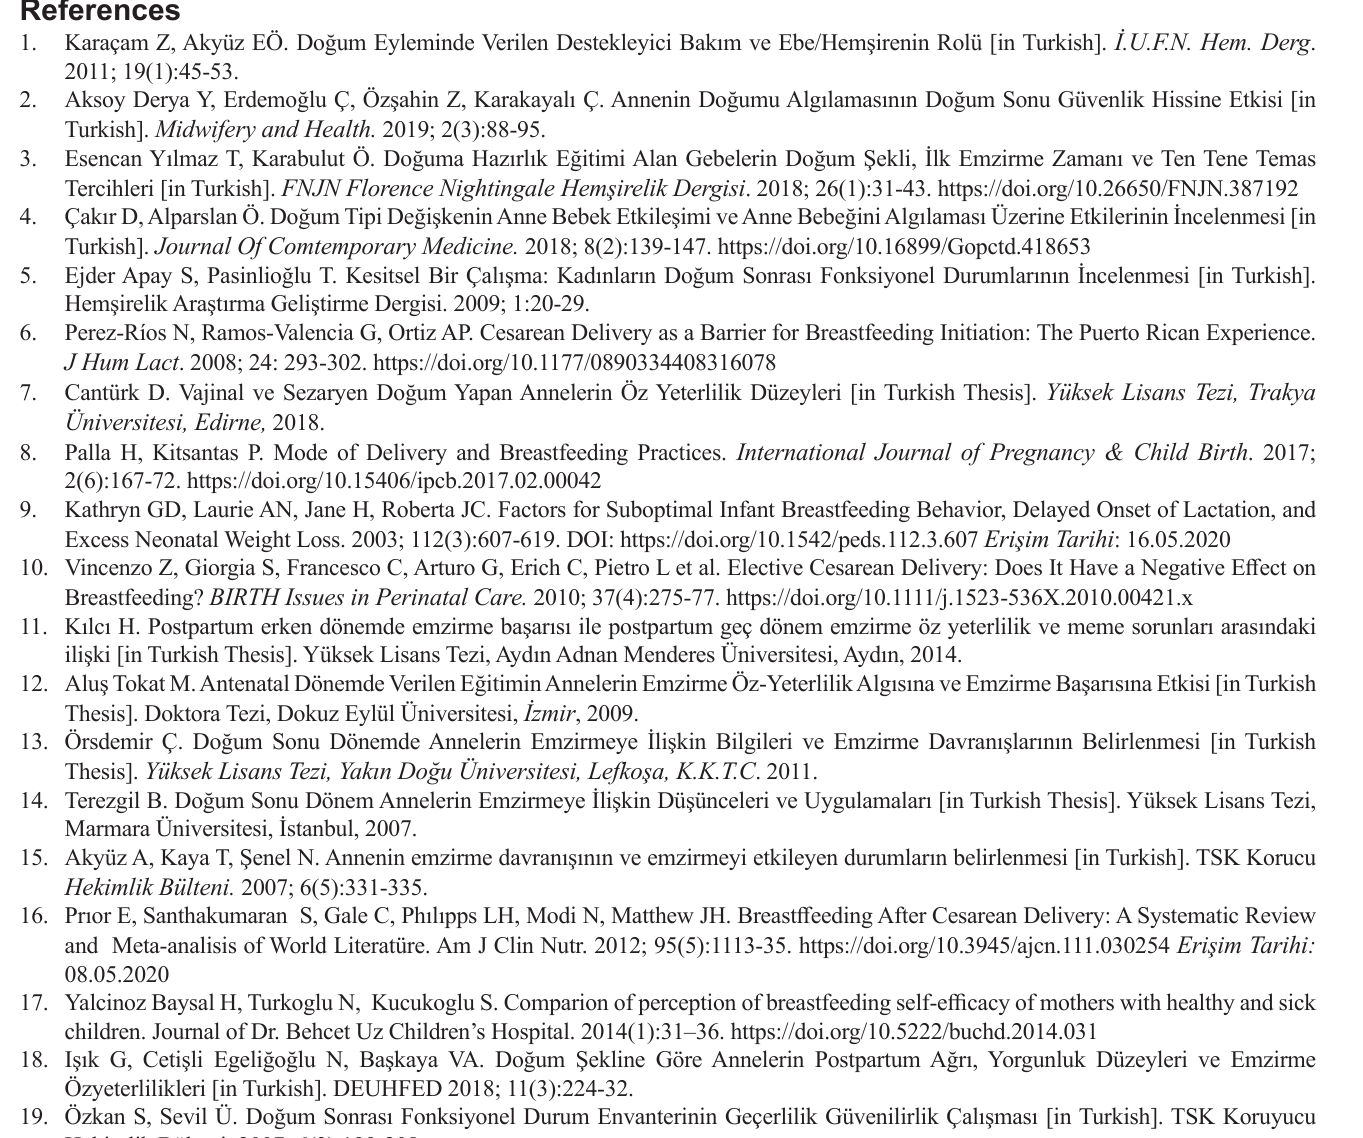
Pearson Correlation